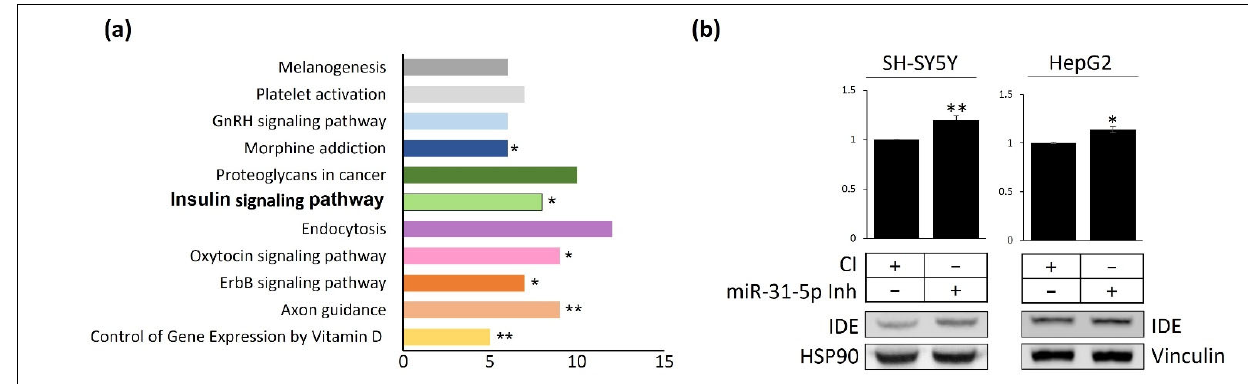
Figure 5. miR ‐ 31 ‐ 5p regulates genes involved in insulin signaling pathway and controls IDE protein at the physiological level ( a ) DAVID analysis showing fractional difference analysis of the top enrichment pathways of miR ‐ 31 ‐ 5p target genes. * p < 0.05; ** p < 0.01 (observed versus expected). ( b ) Representative Western blot analysis of IDE in SH and HepG2 cells transfected with control inhibitor (CI) or miR ‐ 31 inhibitor. HSP90 and Vinculin were used as loading controls.